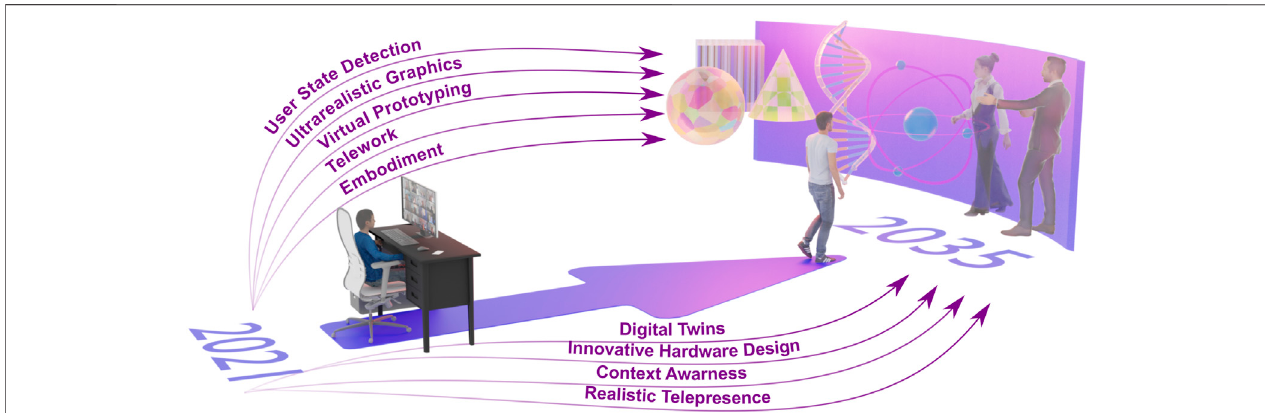
FIGURE 1 | Telelife, the future of remote living. In 2021, we are still bound by our technology and devices, practically locked in front of a stationary display and operatingremotely inan unnatural and often exhausting way. Telelife providesavisionofthe future that lookstowards 2035,where amajority ofourinteractionsand our daily routines will be supported with remote technologies that are aligned with human nature. Telelife integrates learning, exploration, interaction problem solving, and evengamingintoavirtualecosysteminwhichuserswillhaveexperiencesthatarecloselyintegratedintotheirlifestyles.Toachievethisfuture,breakthroughswillbe neededalongvarious researchtopics suchasuserstatedetection,ultrarealistic graphics, virtualprototyping,telework,embodiment,innovativehardwaredesign,digital twins, context awareness and realistic telepresence.